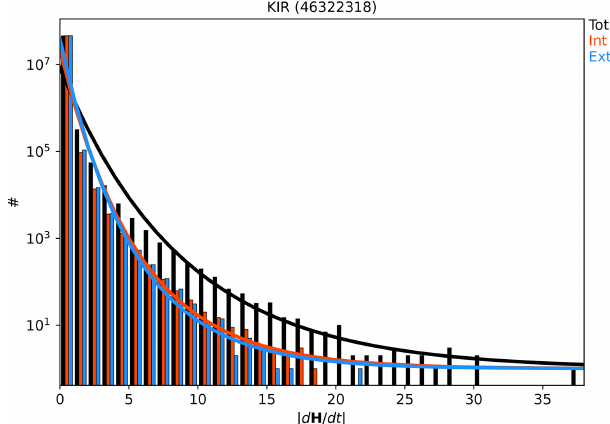
Figure 15. Histogram of all total, internal, and external | d H / d t | values observed by KIR between 1994 and 2018. The total num- ber of data points is indicated in the parenthesis. The curves show a exp − b | d H / d t | function fits to the data points, where a and b are